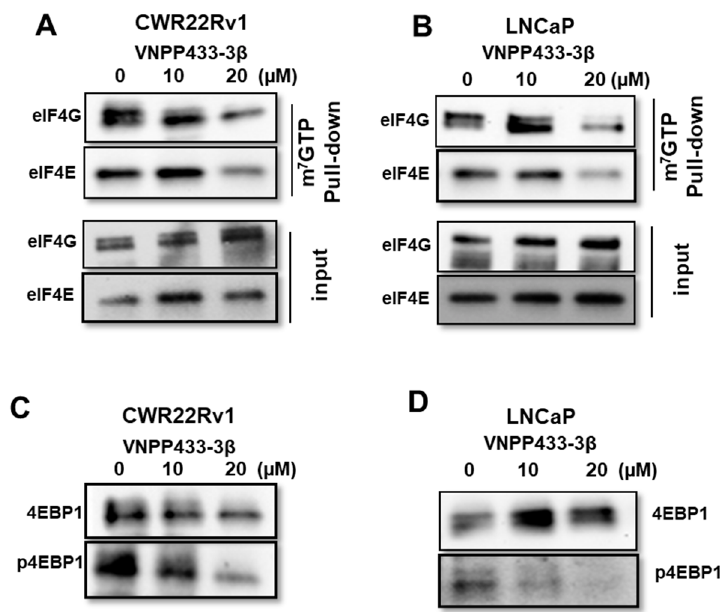
Figure 5. VNPP433-3 β enhances ubiquitin-dependent proteasomal degradation of fAR and AR- V7. ( A , B ) VNPP433-3 β abates binding of eIF4E and eIF4G to 5 ′ cap of mRNA and imposes transla- tional regulation. The mRNA 5 ′ cap binding assay was performed using m 7 GTP-Agarose beads in